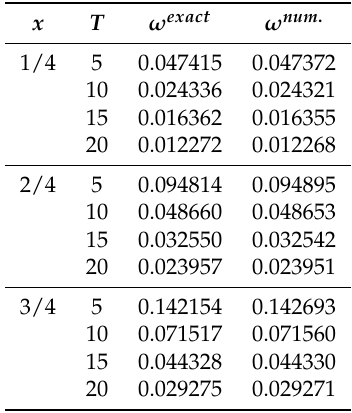
Table 6. Exact and numerical results by present method having ν d = 0.01, ∆ x = 0.0125 and τ = 0.01 at different times T for problem